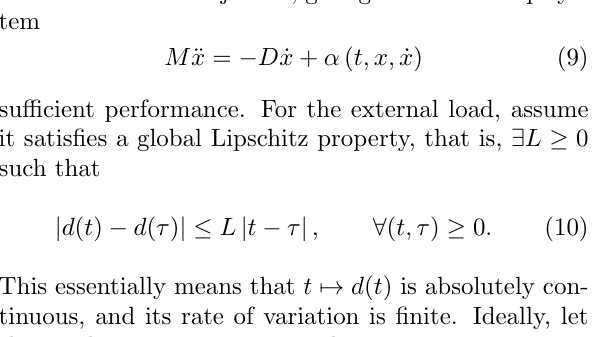
Figure 29: Installation of 4 noncolocated Kongsberg Seatex MRU 5+ inertial sensor units in the NTNU research vessel R/V Gunnerus, for reconstruction of the 6DOF vessel accelera- tion. Courtesy: Kongsberg